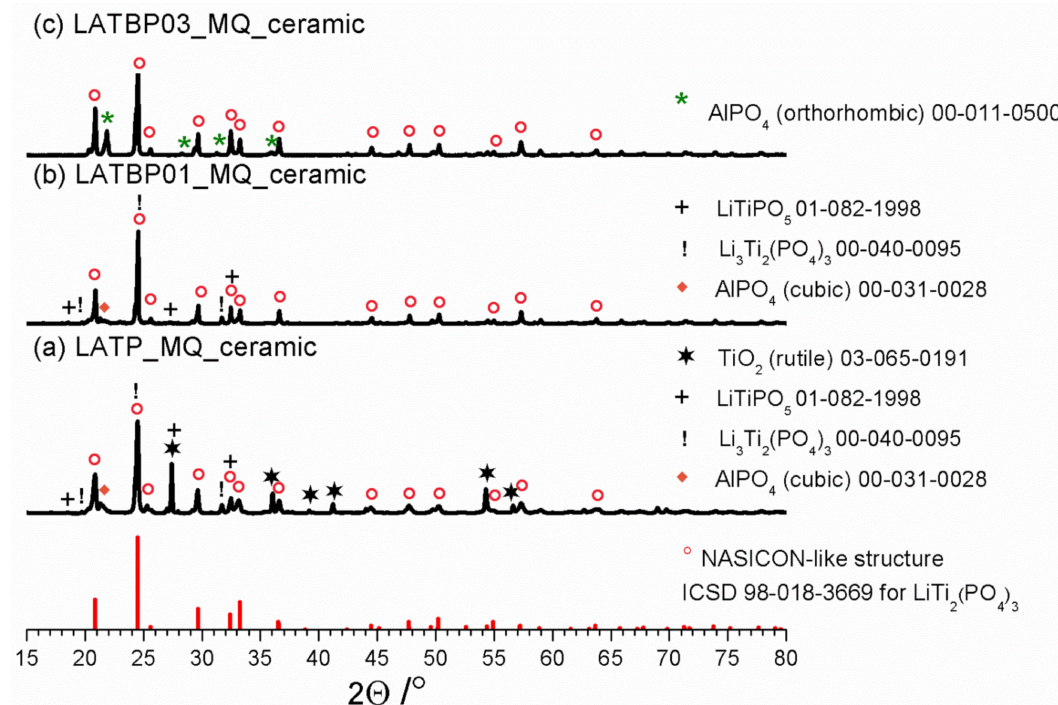
Figure 2. Diffractograms for LAT(B)P_MQ_ceramic series. For comparison ICDD pattern for NASICON-type struc- ture is shown. Peaks ascribed to secondary phases are marked by symbols (see legend). ( a ) LATP_MQ_ceramic ( b ) LATBP01_MQ_ceramic ( c )